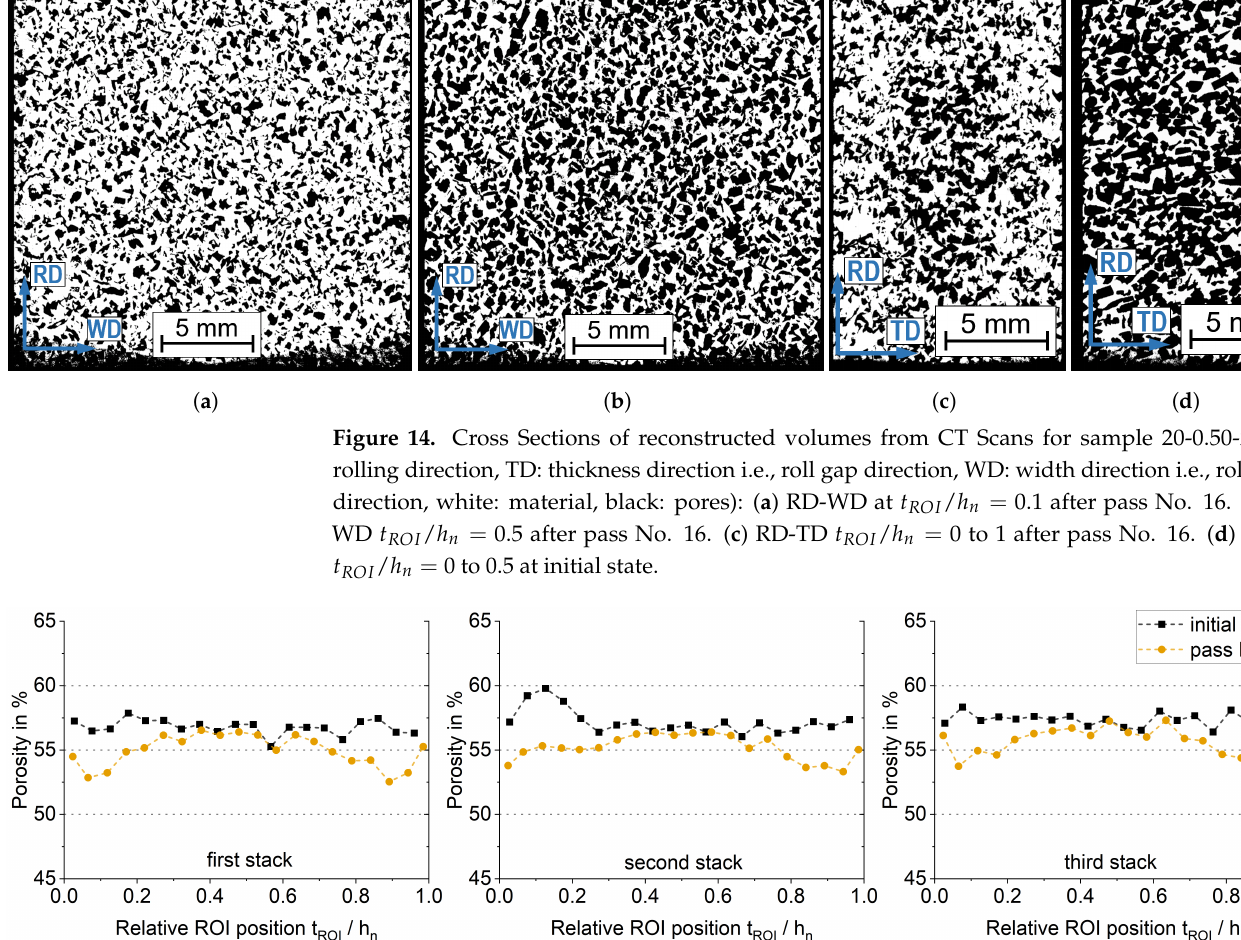
Figure 15. Series I: 20-0.05-1 ( l d / h m ≈ 0.5): Porosity change over relative sample depth (0=upper surface; 0.5= mid-section of sample; 1 =lower surface) due to rolling for first, second and third